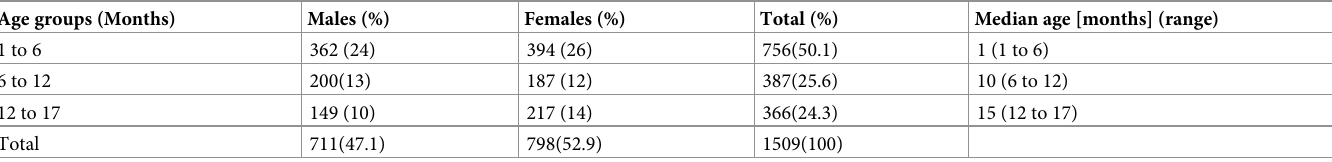
Table 1. Proportion of males and females and the median age for the different age categories.